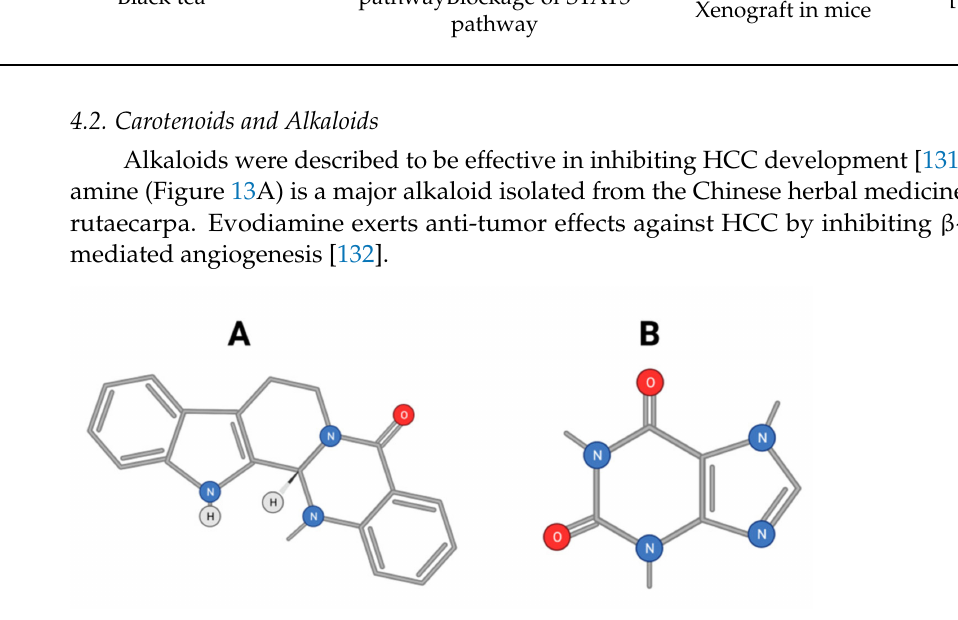
Figure 13. Chemical structure of evodiamine ( A ) and caffeine ( B